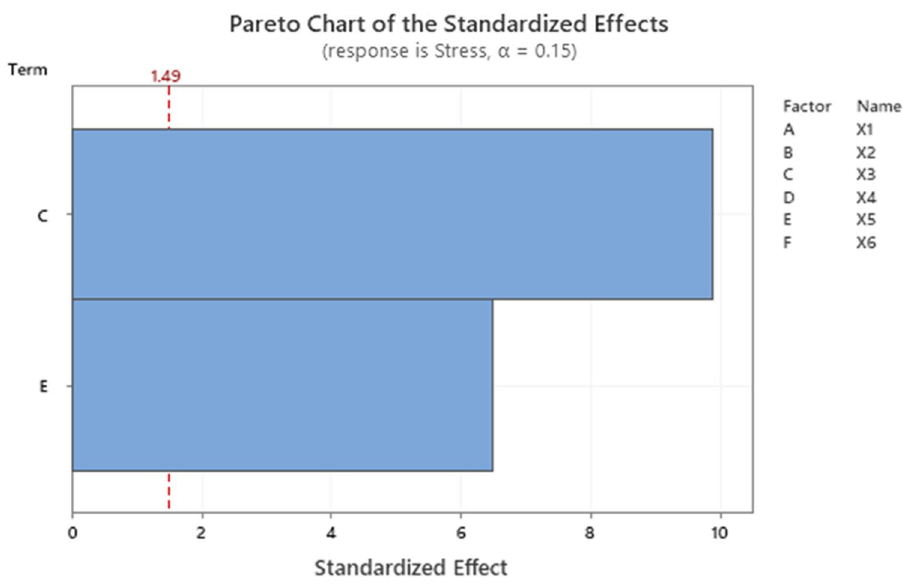
Fig. 11 Pareto chart of stand- ardized effects for both SWLR and BFQMLR of St (only for terms which P value < 0.05. Here 1.50 is threshold)